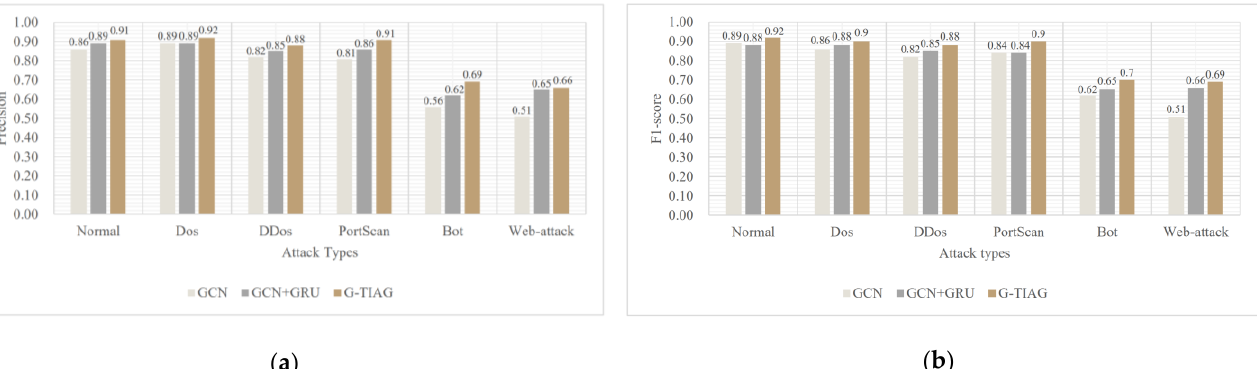
Figure 9. Classification results in ablation study. ( a ) Precision in ablation study. ( b ) F1-Score in ablation study.